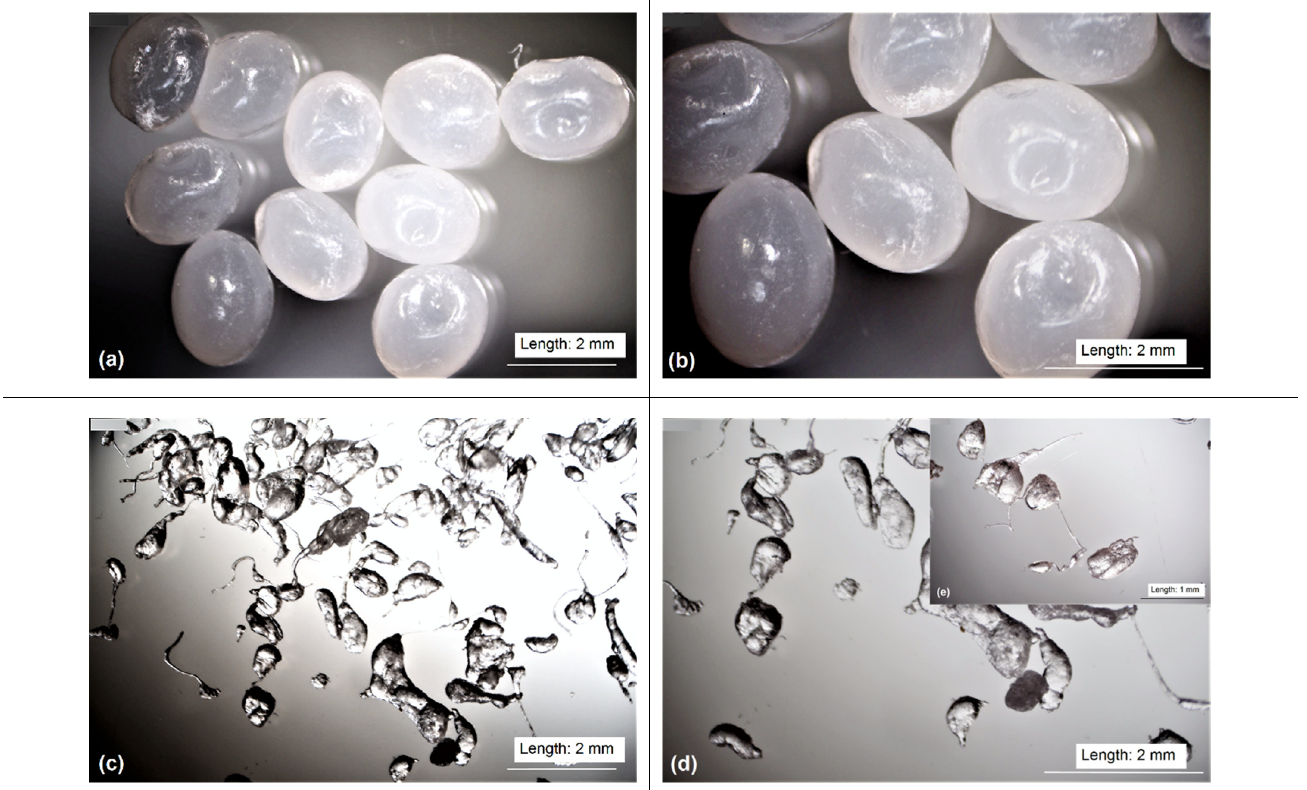
Figure 1. Microscopic pictures of PLA granules: ( a )—×7 magnification, ( b )—×10 magnification and PLA powder: ( c )—×7 magnification, ( d )—×10 magnification, ( e )—×15 magnification. PLA powder: ( c )— × 7 magnification, ( d )— × 10 magnification, ( e )— × 15